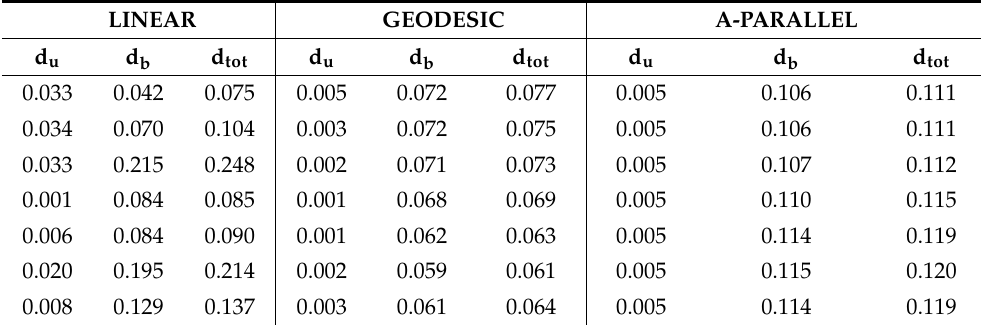
Table 3. Values of the energies for the non-affine case of bending: d u represents the affine component of the Γ -energy, d b the non-affine component, and d tot the total Γ -energy. LINEAR GEODESIC A-PARALLEL